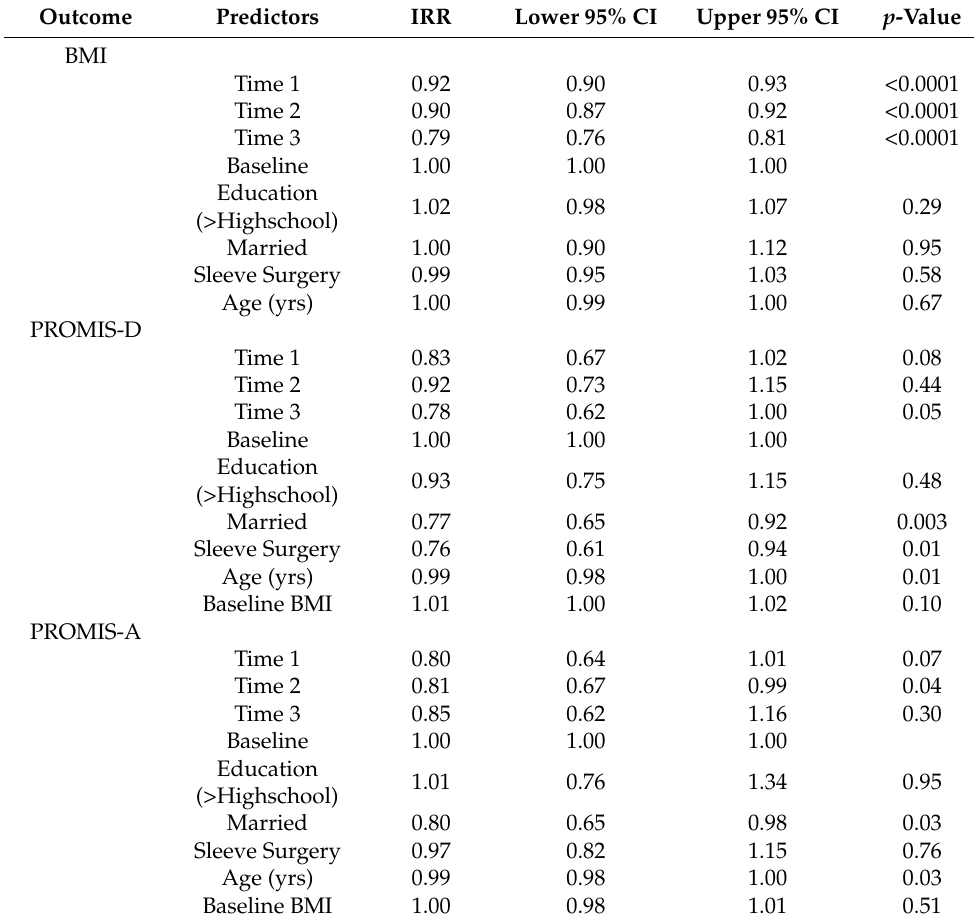
Table 2. Generalized Estimating Equation with negative binomial distribution Incident Rate Ratio (IRR) results, main effect of time plus all